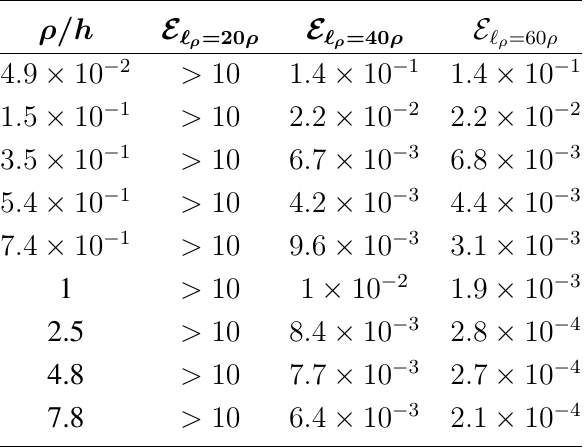
Table 6. Error for increasing ρ , various support widths ℓ mesh, and inclined interface with α = 30 ◦